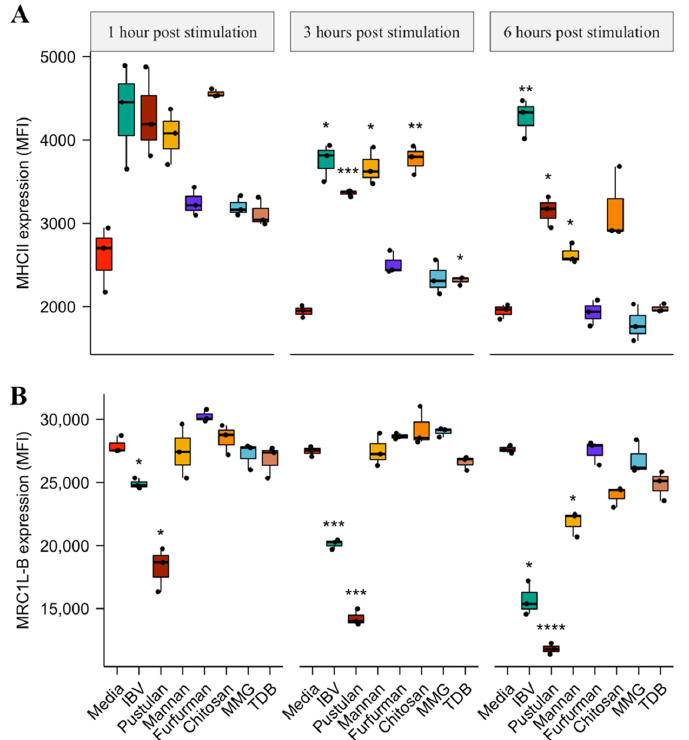
Figure 1. Glycan-based ligand induced effect on bone marrow-derived dendritic cell (BM-DC) MHC class II (MHCII) and MRC1L-B surface expression. BM-DC MHC-II expression ( A ) and